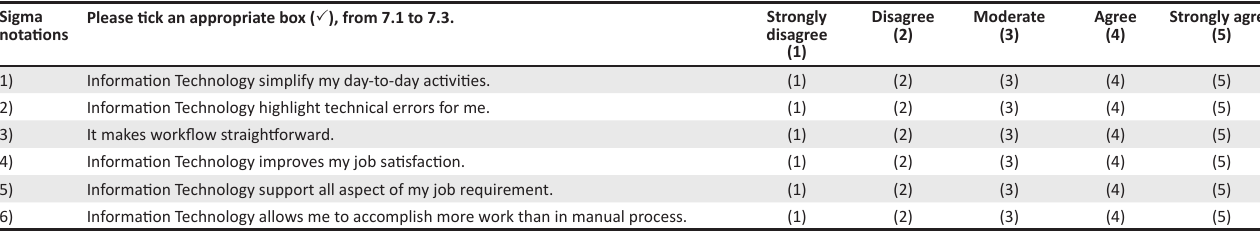
TABLE 1-B1: Actual adoption of enterprise application